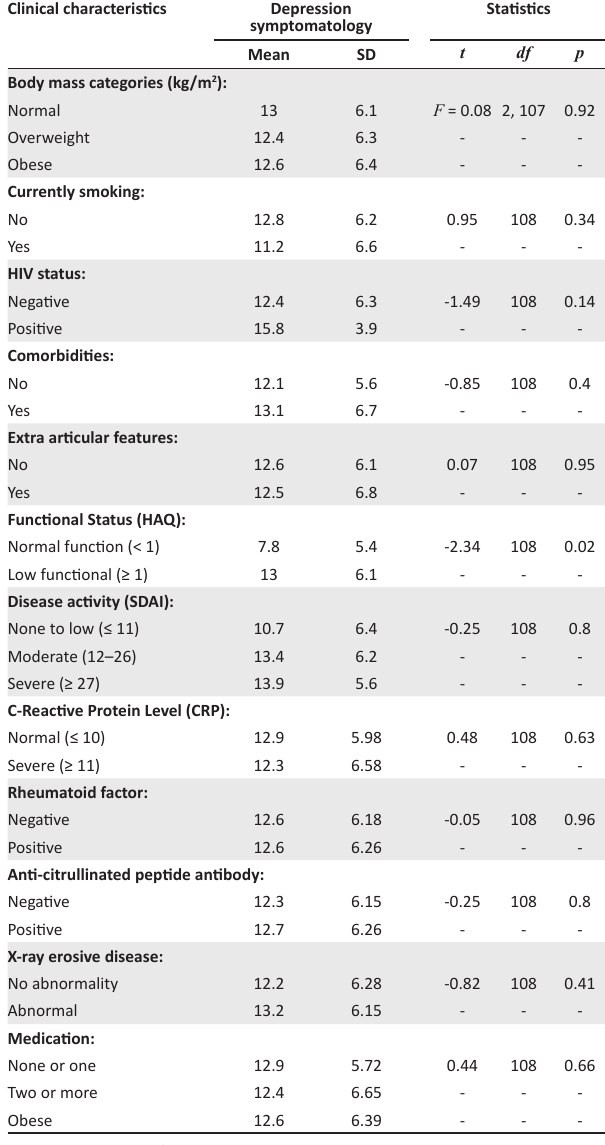
TABLE 4: Association of depression symptomatology by clinical